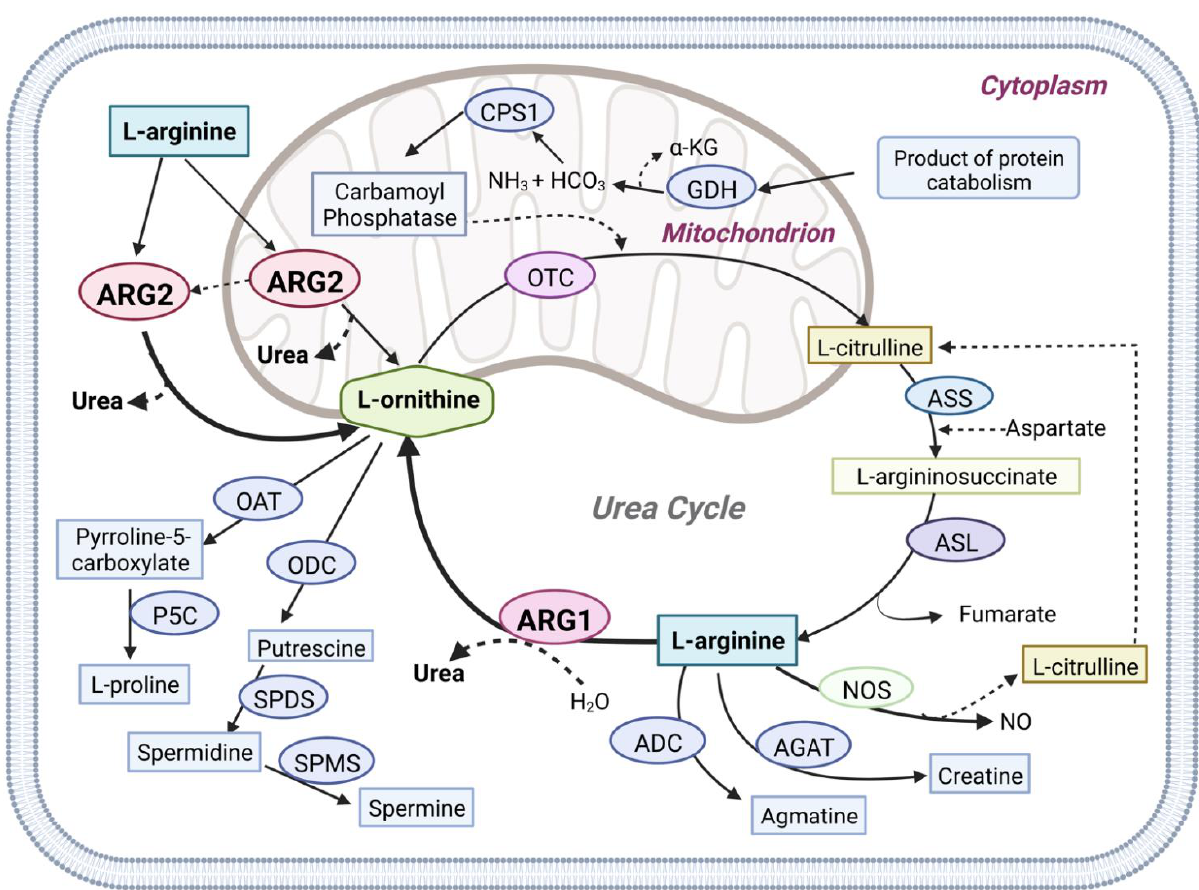
Figure 1. Graphical overview of Arginase1 (ARG1) and Arginase2 (ARG2) mediated L-arginine me- tabolism in physiologic pathways. Arginase1 (ARG1), nitric oxide synthases (NOS), arginine decar- boxylase (ADC), and L-arginine: glycine amidinotransferase (AGAT) use L-arginine as the primary metabolic substrate. Arginase1, the final enzyme of the urea cycle, cleaves L-arginine to form urea and ornithine in the cytoplasm. Arginase2 (ARG2) is also involved in the urea cycle L-arginine me- tabolism in both the cytoplasm and mitochondria. N-acetyl glutamate synthase (NAGS), carbamoyl phosphate synthase (CPS1), ornithine transcarbamylase (OTC), argininosuccinate synthetase (ASS), argininosuccinate lyase (ASL), glutamate dehydrogenase (GDH), ornithine aminotransferase (OAT), ornithine decarboxylase (ODC), Δ1 -pyrroline-5-carboxylate synthase (P5C), spermidine syn- thase (SPDS), spermine synthase (SPMS).